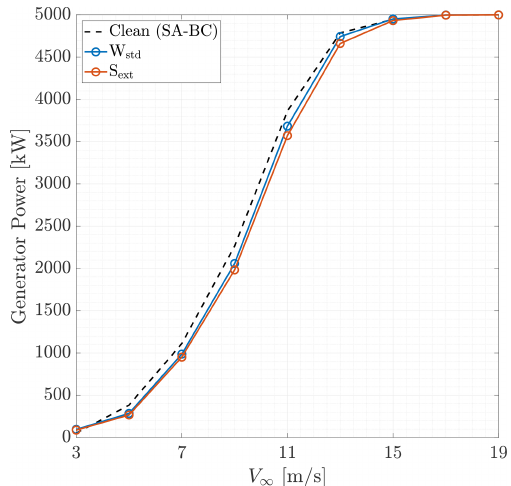
Figure 26. Power curve with a turbulent inflow.